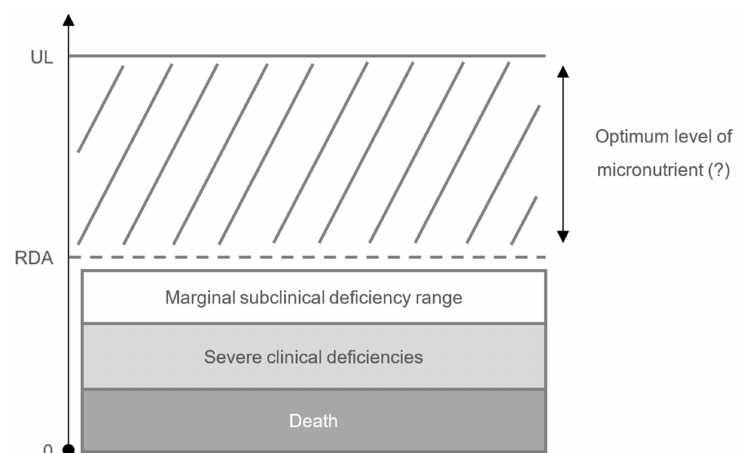
Figure 3. For optimal immune protection and resistance to infection, daily intakes may need to be much higher than the RDAs [24,27]. Abbreviations: RDA, recommended dietary allowance [143]; UL = tolerable upper intake level, the maximum daily intake unlikely to cause adverse health e ff